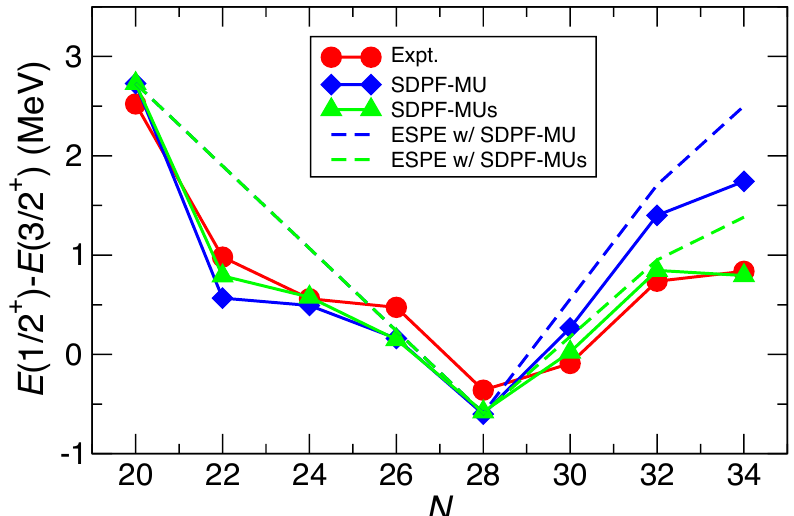
) − E ( 3/2 + ) in neutron-rich 1 1 − ε = ε − ε π s ) for the π d 3/2 π ( d 3/2 ) − 1 1/2 1/2 ) − 1